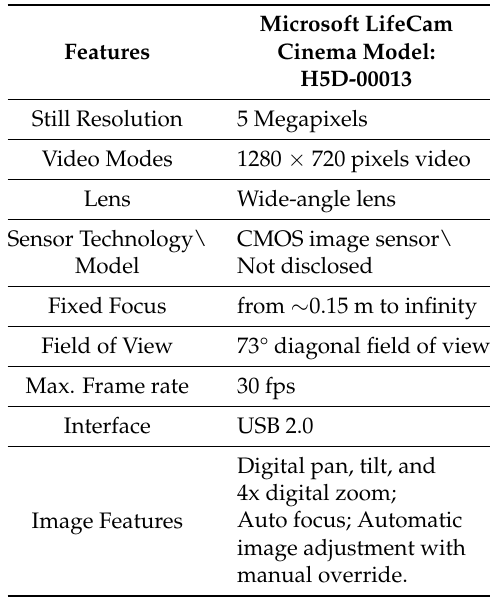
Table 2. Parameters description of the cameras used in the